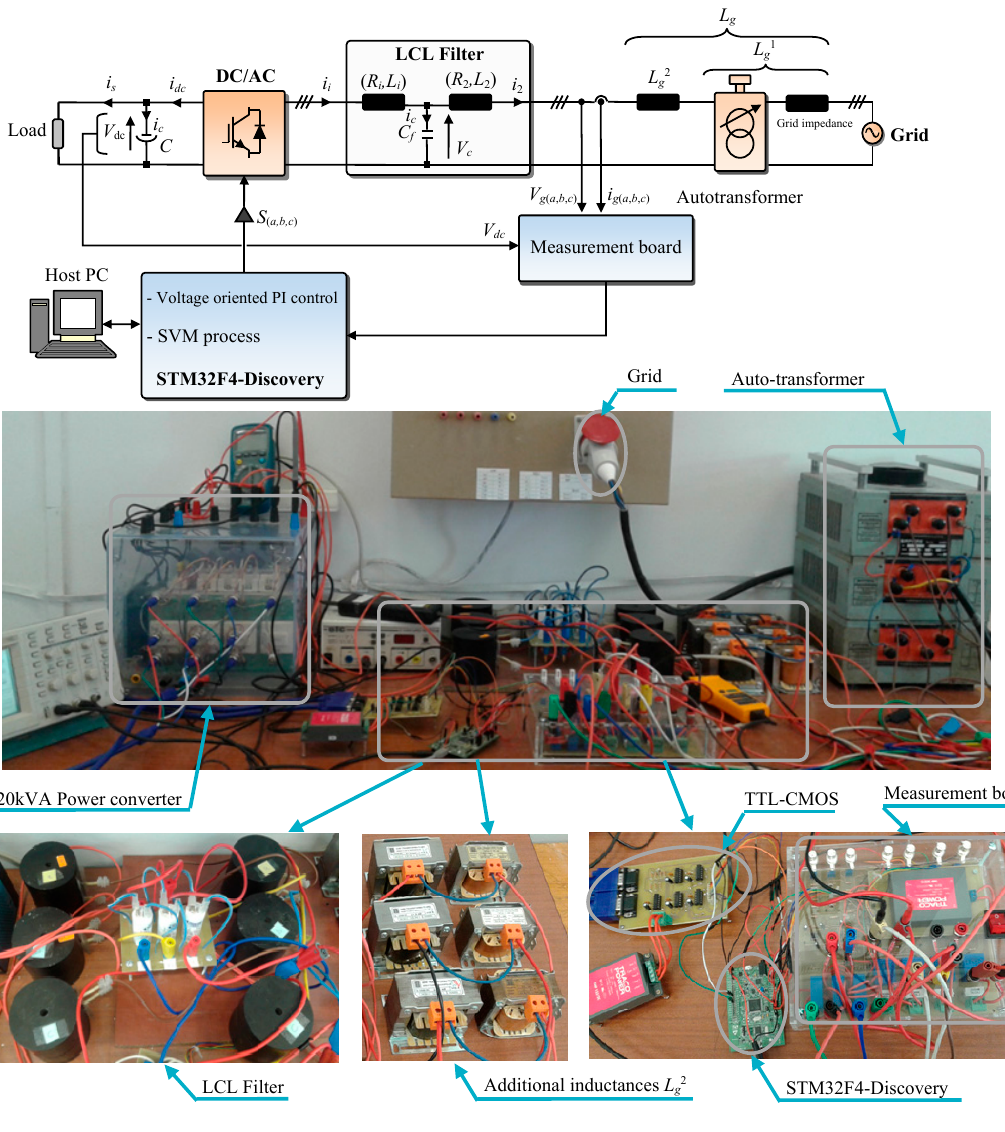
Figure 13. Experimental set-up. Energies 2017 , 10 , 336